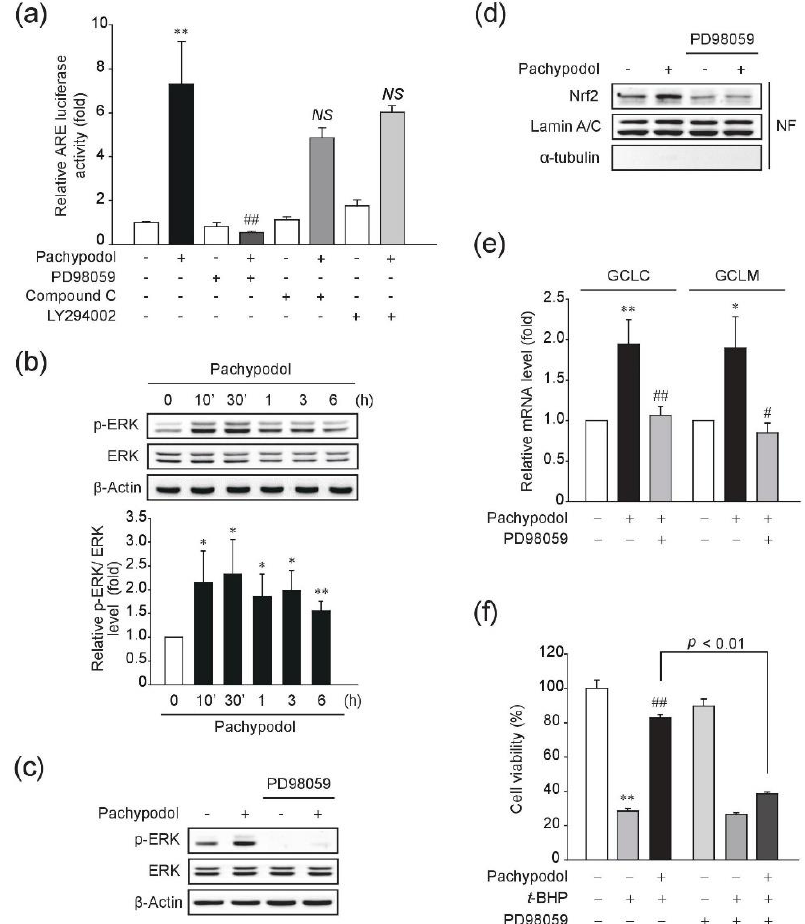
Figure 5. Role of ERK activation in the Nrf2 activation and cytoprotection by pachypodol. ( a ) The ARE-luciferase activity was measured in the lysates of pGL4.37 plasmid stably transfected HepG2 cells that had been exposed to pachypodol (30 µ M, 12 h) after pretreatment with 10 µ M PD98059, a MEK inhibitor, 1 µ M Compound C, an AMPK inhibitor, or 10 µ M LY294002, a PI3K inhibitor for 1 h; ( b )Thetime-dependentERKphosphorylationbythetreatmentof30 µ MpachypodolinHepG2cellswere assessed by Western blot analysis. Bands were quantified by densitometric scanning. The expression levels of phosphorylated ERK were normalized to those of its total form; ( c ) ERK inhibition by PD98059 was verified by immunoblotting in the lysates of HepG2 cells exposed to pachypodol (30 µ M, 30 min) after 1 h pretreatment with PD98059 (10 µ M); ( d , e ) Nuclear Nrf2 levels or GCLC and GCLM mRNA levels were determined in HepG2 cells exposed to pachypodol (30 µ M, 6 h) after 1 h pretreatment with PD98059 (10 µ M). Lamin A / C (a nuclear protein) was used as a loading control and the purity of nuclear fraction was verified by immunoblotting for α -tubulin (a cytosolic protein); ( f ) HepG2 cells were treated as described in the legend to Figure 2b in the presence or absence of PD98059 (10 µ M). Cell viability was assessed by an MTT assay. Data represent the mean ± S.D. ( n = 3–4). * p < 0.05, ** p < 0.01 (compared with the DMSO-treated vehicle control); # p < 0.05, ## p < 0.01 (compared with the pachypodol-treated group or t -BHP alone); AMPK, AMP-activated protein kinase; GCLC, catalytic subunit of glutamate-cysteine ligase; GCLM, modifier subunit of glutamate-cysteine ligase; MEK, mitogen-activated protein kinase kinase; NF, nuclear fraction; NS , not significant; PI3K, phosphatidylinositol